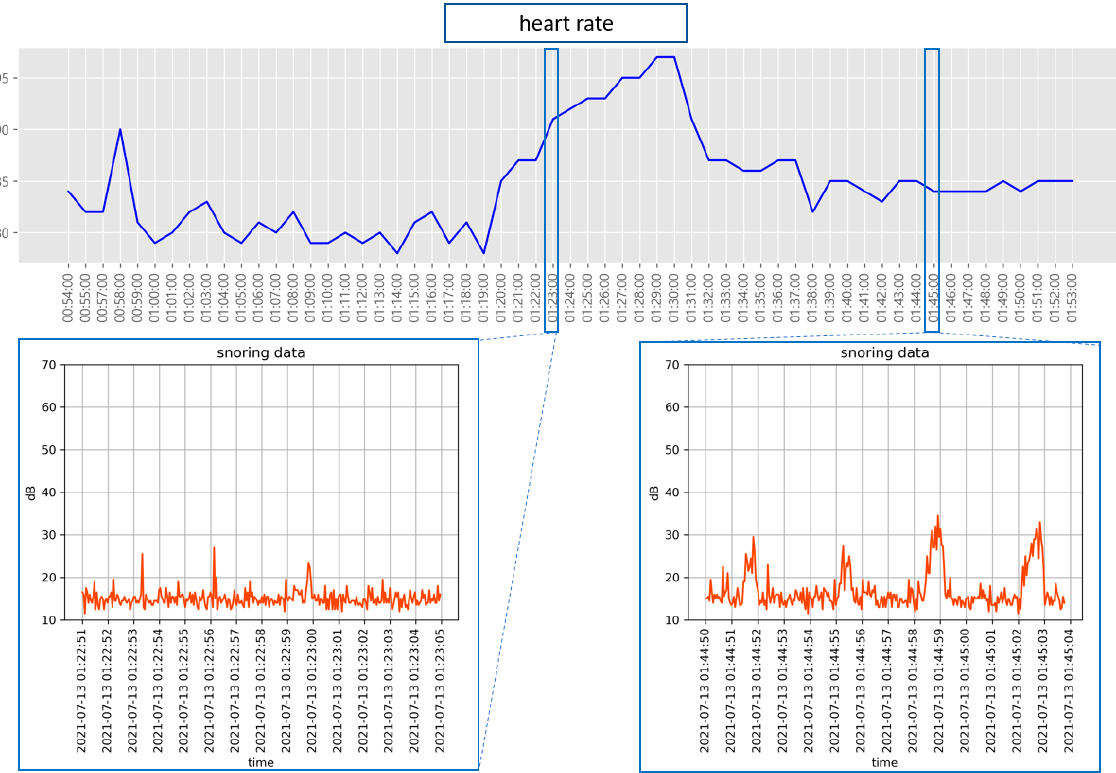
Figure 16. Comparison of snoring sound and heart